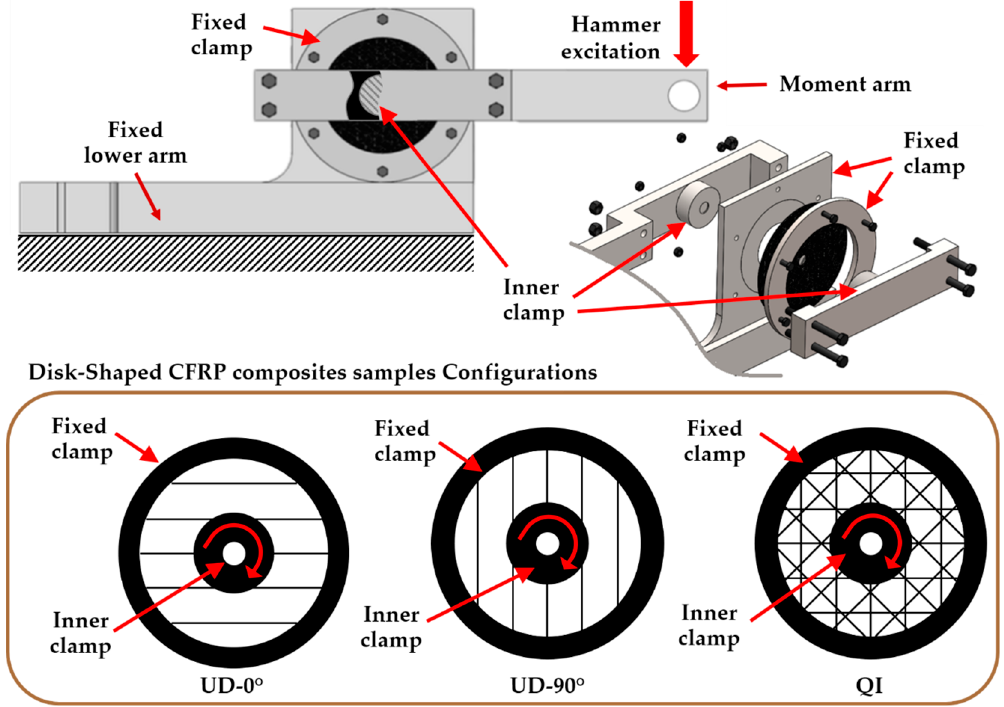
Figure 2. Drawing of the designed frame setup and disk-shaped sample configurations. CFRP—carbon fiber-reinforced polymer.